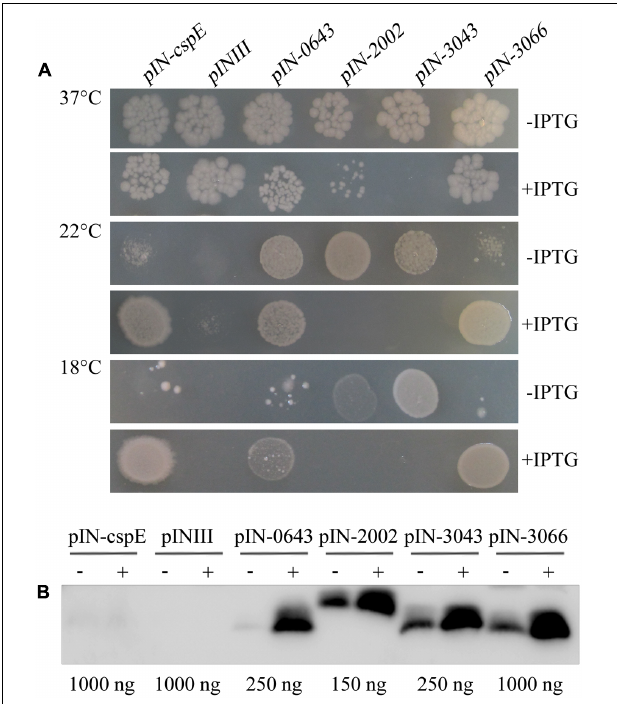
FIGURE 2 | Archaeal TRAMs complemented the cold sensitivity of Escherichia coli BX04. (A) E. coli BX04 carries a quadruple deletion of cspA , B , G, and E genes, and its growth below 15 ◦ C is retarded. Cultures of E. coli strains overexpressing each of Mpsy_0643 , Mpsy_2002 , Mpsy_3043 , Mpsy_3066 , and cspE were adjusted to an optical density at 600 nm of 0.9 by dilution with fresh medium. Cultures were serially diluted 10 − 5 -fold and spotted onto LB plates supplemented with ampicillin. The plates were incubated at 18, 22, and 37 ◦ C for 2–5 days with or without IPTG, as indicated (Supplementary Figure The pINIII cultures carry the empty plasmid vector. (B) Using the antibody against TRAM2002, a Western blot was performed to determine the abundance of four TRAM proteins in E. coli BX04. The empty plasmid pINIII and bacterial CspE were included as negative controls. The amount of loaded total protein for each TRAM gene cloned strain is shown beneath the gel. ± on the top of each lane indicates the presence or absence of